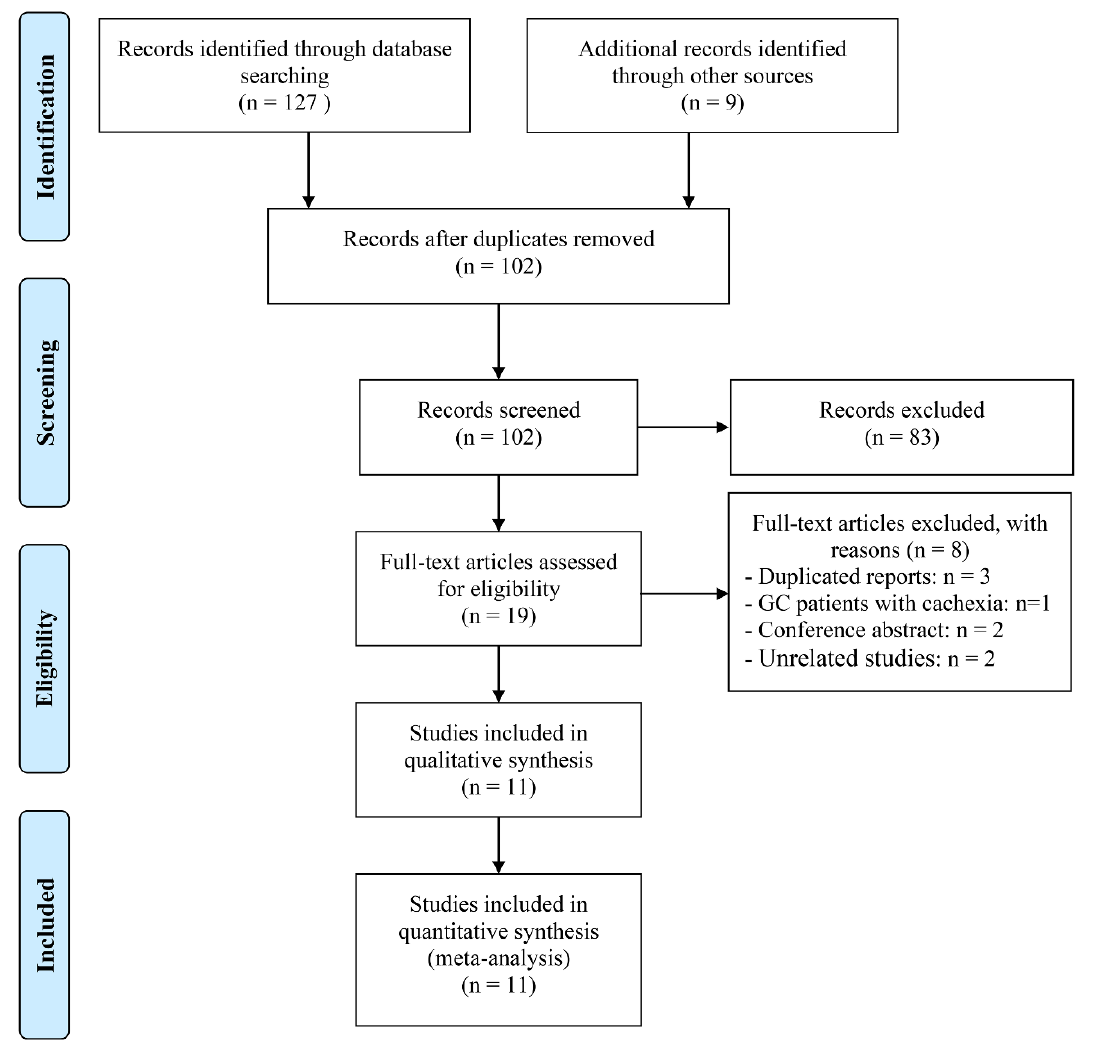
Figure 1. The flow diagram of identifying eligible studies.